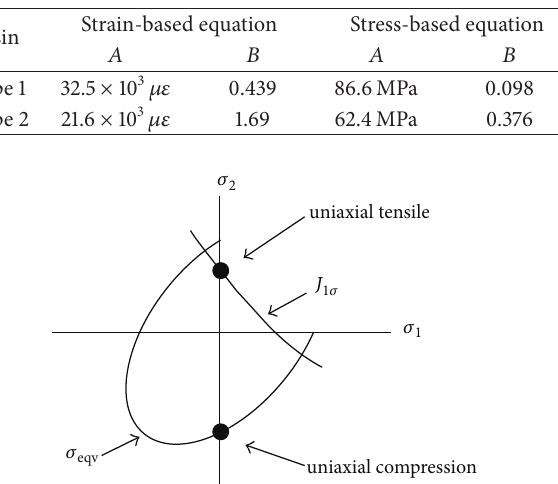
Figure 2: Failure envelope for a polymer described in